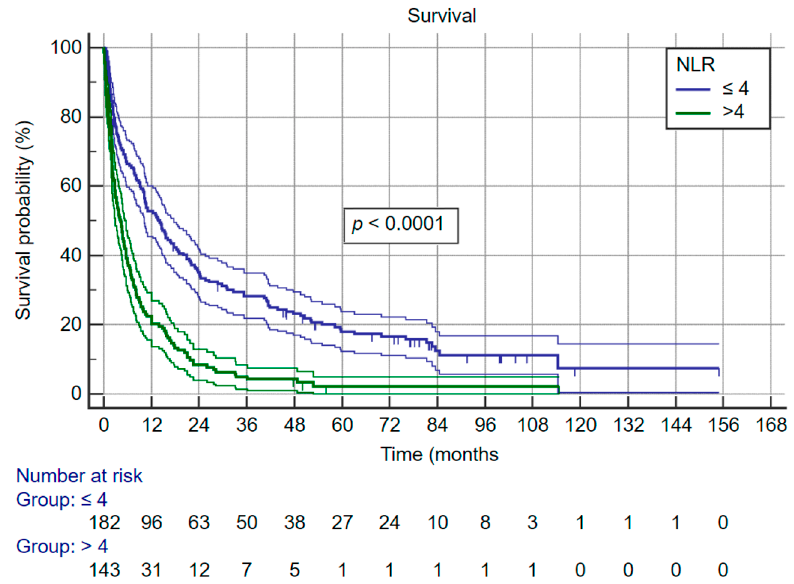
Figure 4. Kaplan–Meier survival curves for whole cohort, split by neutrophil–lymphocyte ratio categories.